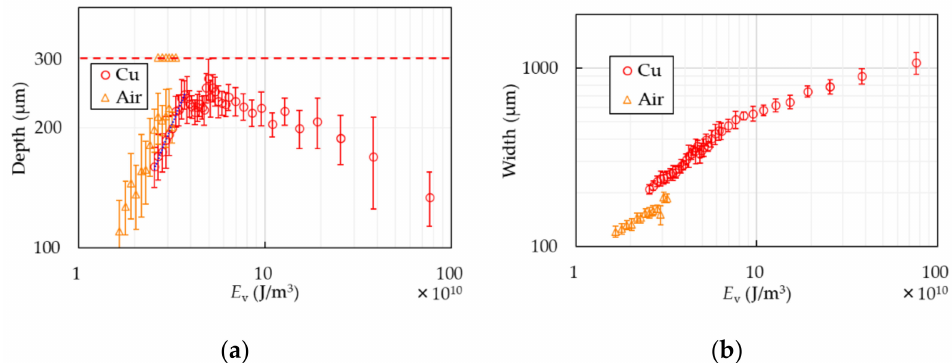
Figure 6. Depth ( a ) and width ( b ) of PP are shown. The circles show the results of the Cu cooling base and the triangles show that of air. The dash line in ( a ) represents the sample thickness. Two triangles at the same E v in ( a ) mean partially penetration. The blue dot-line in ( a ) represents linear approximation to the results of the Cu base in the range of the monotonic